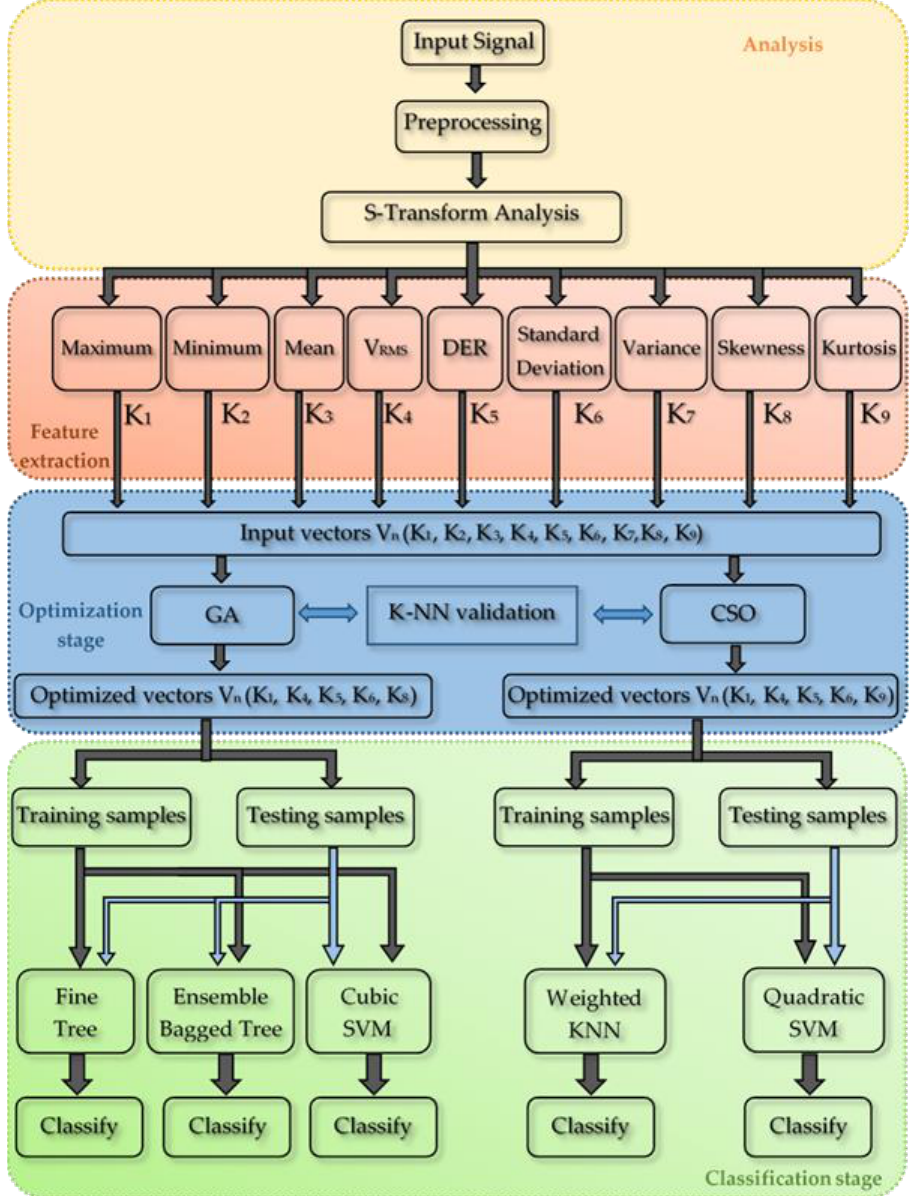
Figure 4. Comparative flowchart of the proposed disturbance classification.